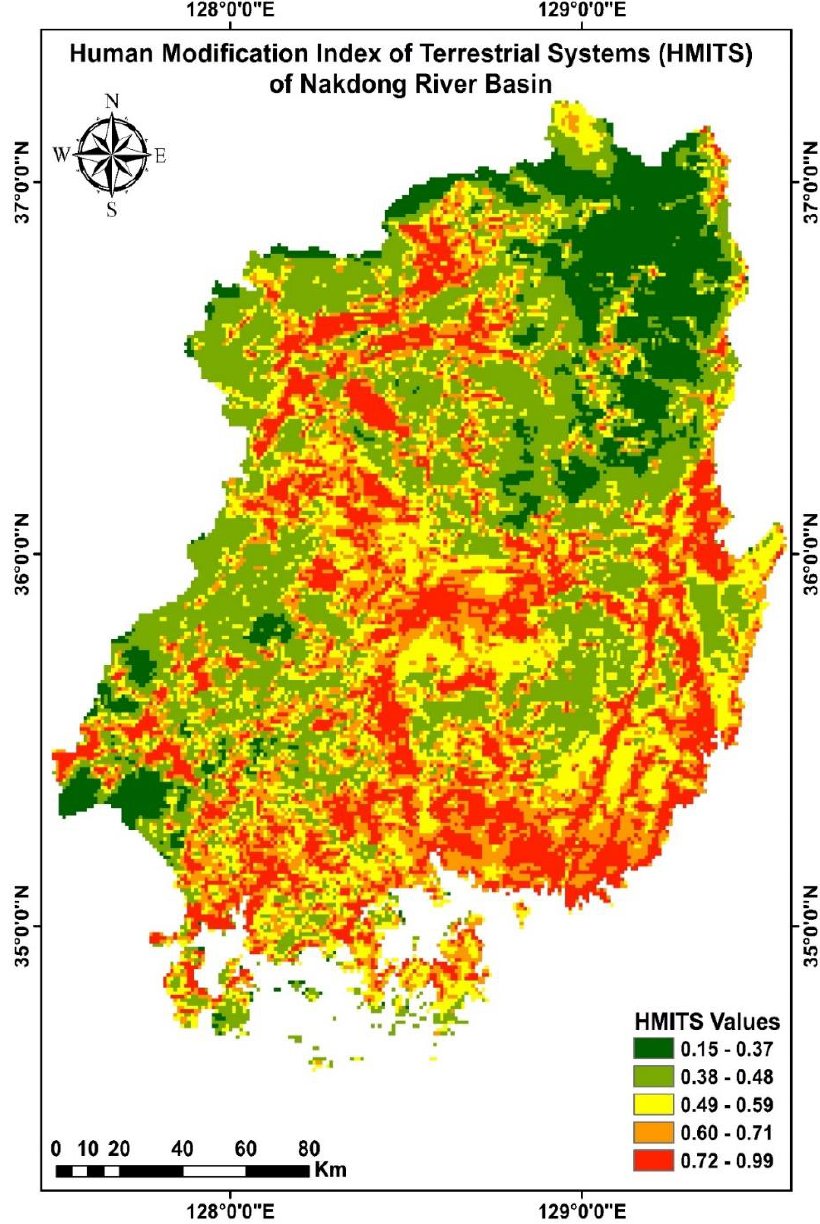
Figure 2. Human modification index of terrestrial systems (HMITS) of Nakdong River basin.